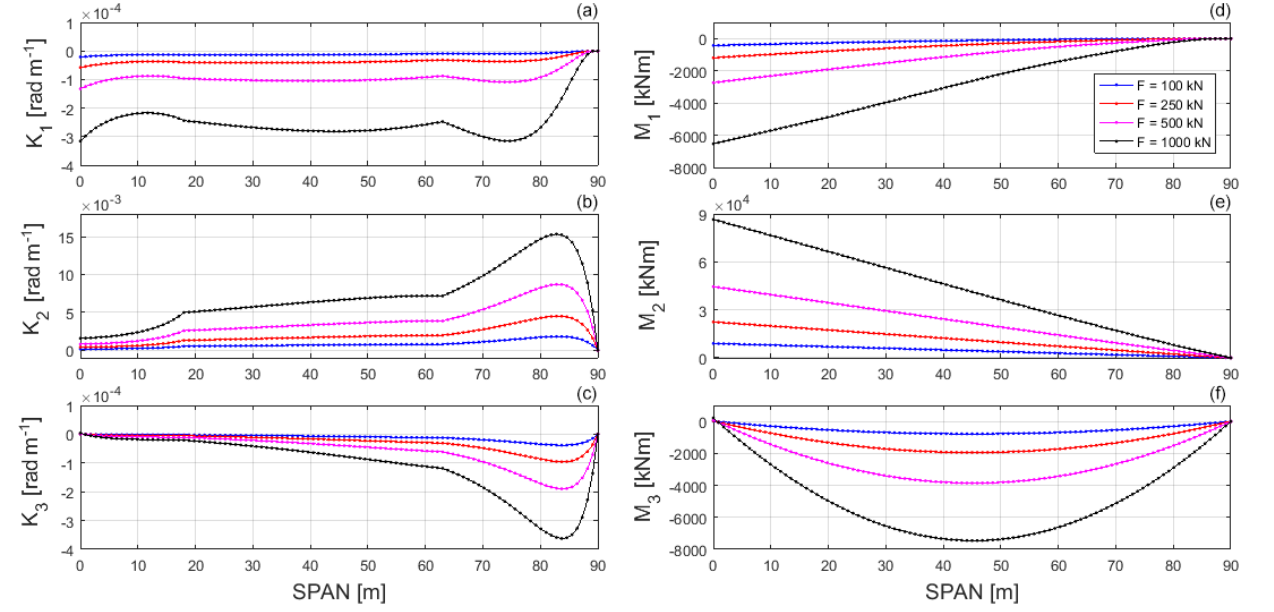
Figure 8. Changes in curvature (a–c) and moment stress resultants (d–f) with 3D BLM for increasing F .